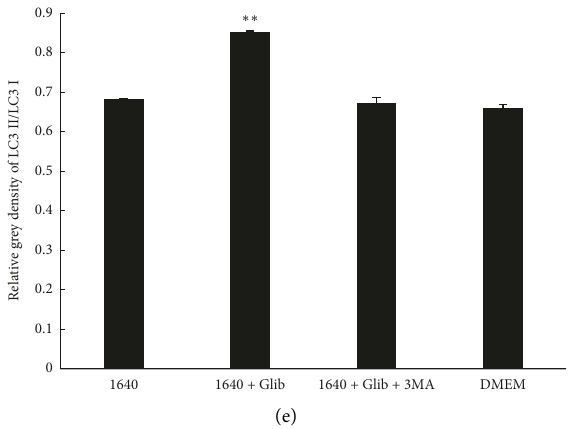
Figure 3: Glibenclamide-induced autophagy may inhibit its ability to promote insulin secretion in MIN-6 cells. (a) The different treatments of MIN-6 cells for insulin secretion level; ∗ P < 0 . 05, 1640 vs. 1640+Glib10; ∗∗ P < 0 . 01, 1640 vs. 1640+Glib10+3-MA. (b) Statistical results of cell immunofluorescence test. ∗ P < 0 . 05, 1640 vs.1640+Glib10. Data shown are mean ± SEM of values from at least 30 cells with triplicate samples. (c) Cell immunofluorescence analysis. MIN-6 cells were stained with an anti-LC3 antibody and observed with a laser confocal microscope (scale bar: 5 μ m). (d) LC3 turnover assay and the relative grey density of